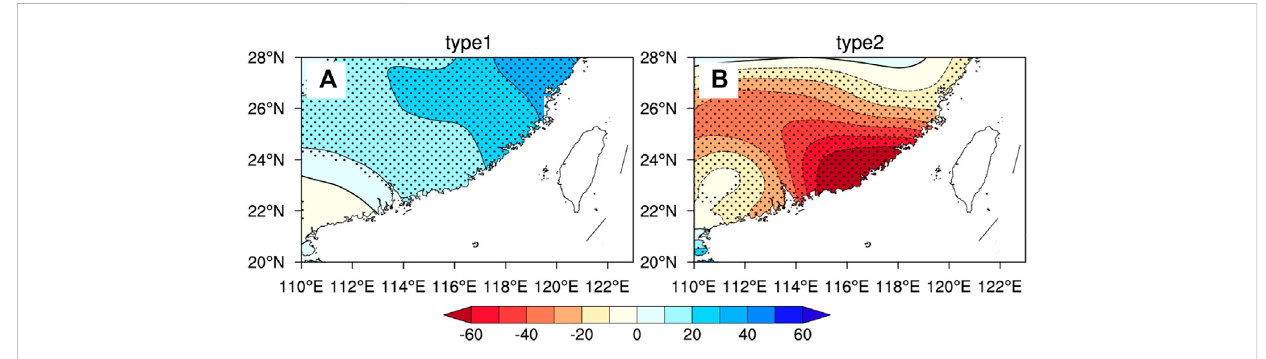
FIGURE 14 Composition of midsummer precipitation anomalies in South China in different phase years of zonal relative position index anomalies during 1979 – 2019. (A) and (B) are types 1 and 2; unit: